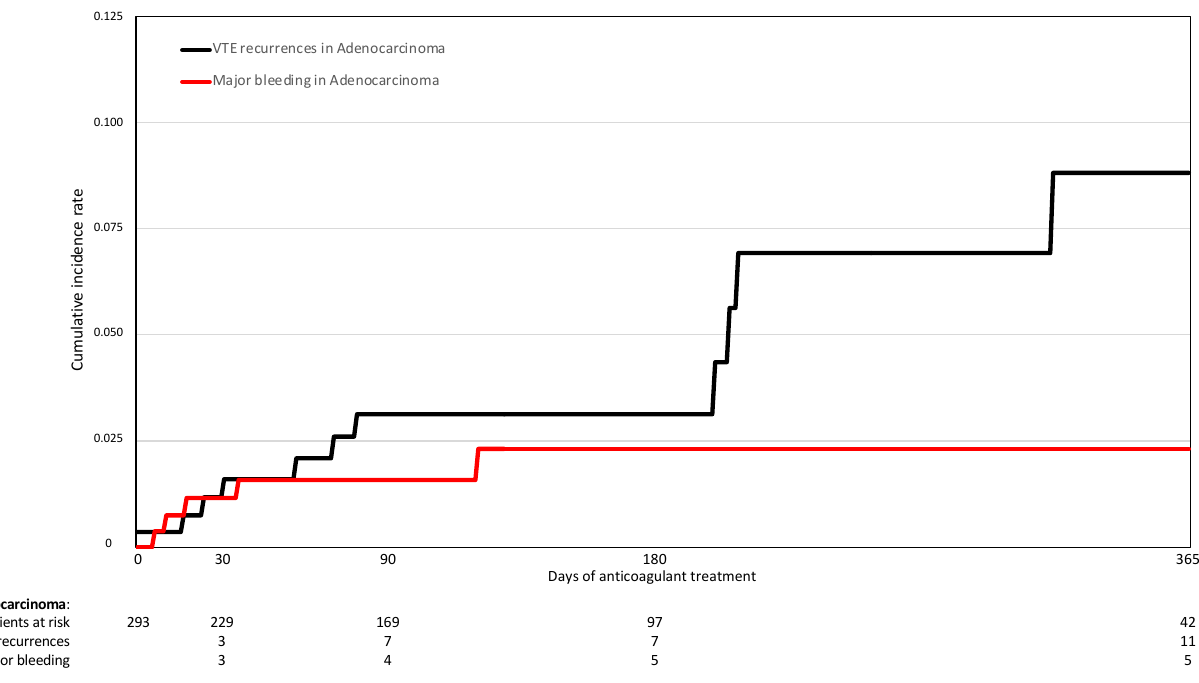
Figure 1. VTE recurrences and major bleeding while on anticoagulant treatment for patients with adenocarcinoma lung cancer.